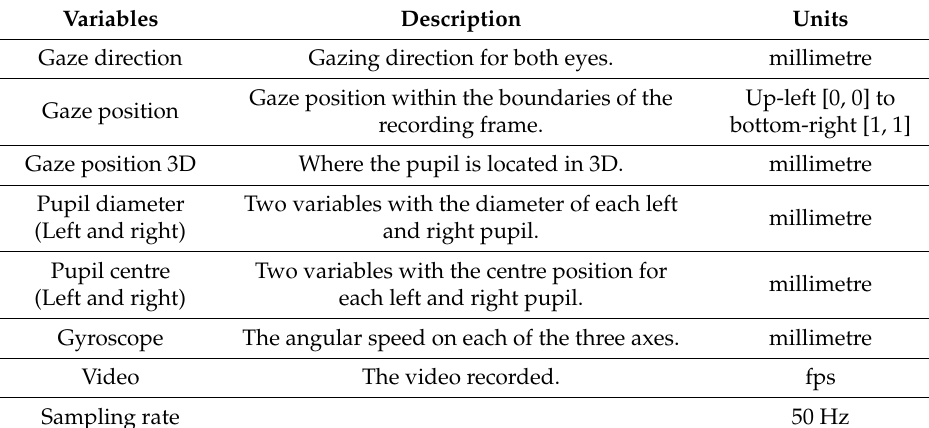
Table 3. Captured variables with the Eye Tracking glasses.